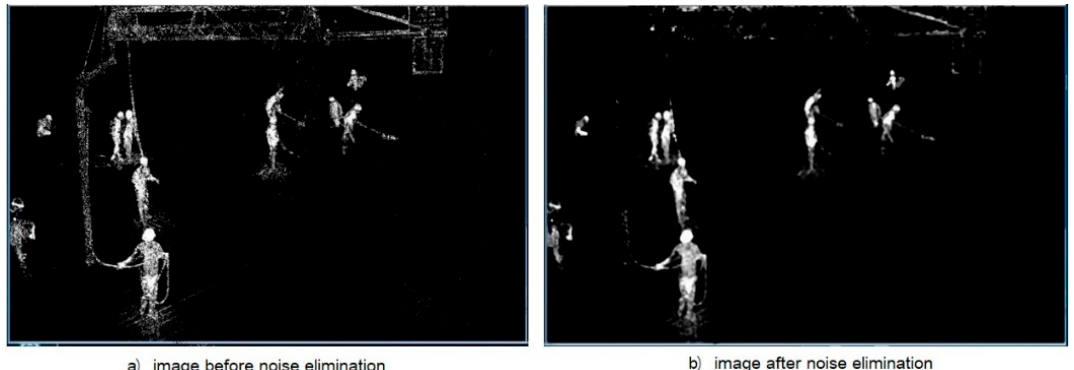
Figure 6. Noise elimination.